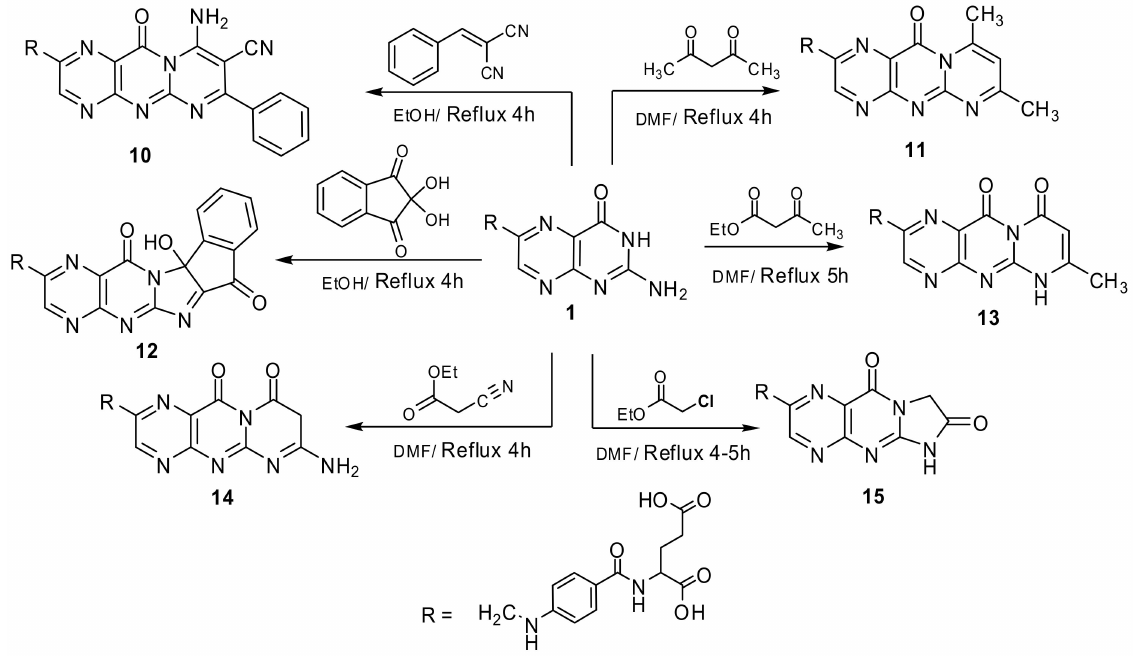
Scheme 2. Synthesis of some new fused systems built on folic